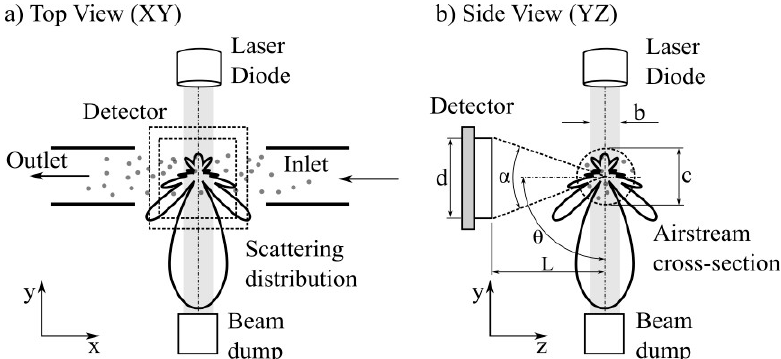
Figure 1. ( a ) Optical particle sensor system with its components (modified from [4]), viewed from the top, ( b ) and same sensor viewed from the side. In our example, we set the θ to 90° and α to 53° in both